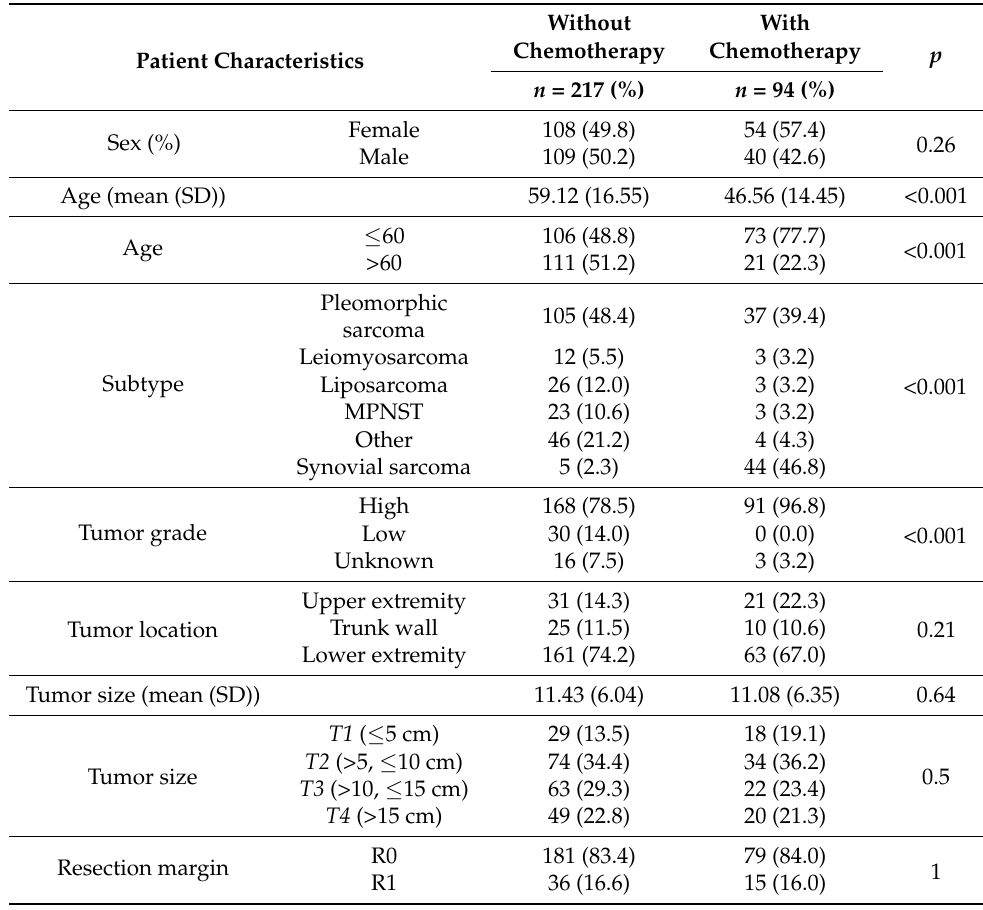
Table 2. Characteristics of patients without or with perioperative